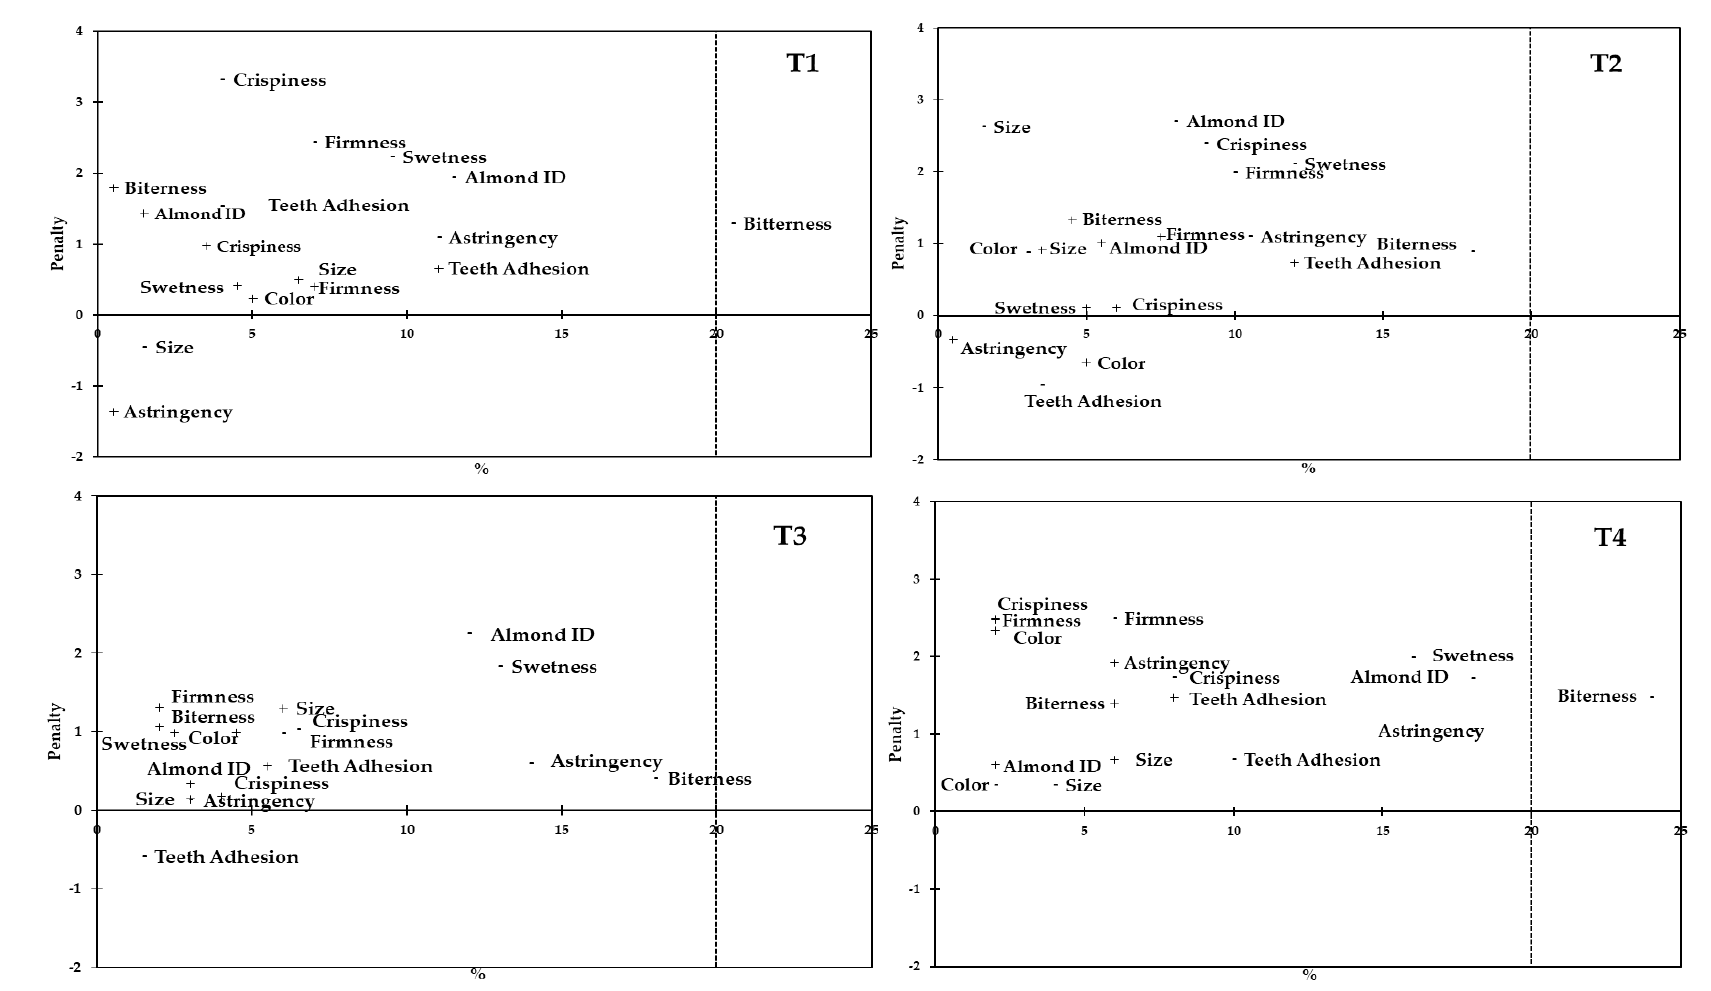
Figure 2. Penalty analysis of attributes intensities assessed by consumers (sample code indicated on the top right of each figure; “too low intensity” is indicated by the symbol “ − “, and “too high intensity” is indicated by the symbol “+”).